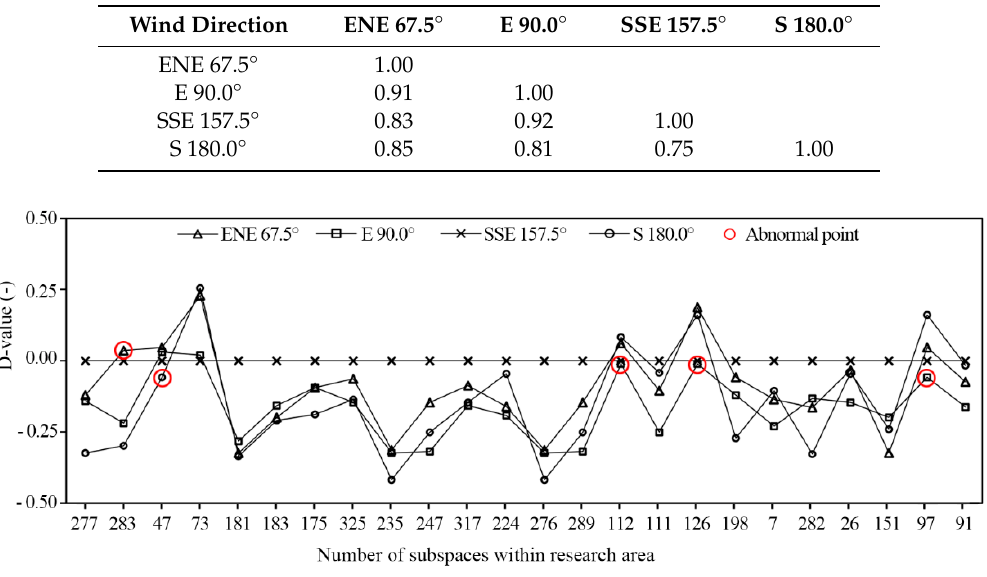
Figure 11. Difference values (D-values) of U (cid:2902) (cid:3364)(cid:3364)(cid:3364)(cid:3364) between the other three wind directions and Figure 11. Di ff erence values (D-values) of U R between the other three wind directions and SSE 157.5 ◦ SSE 157.5°